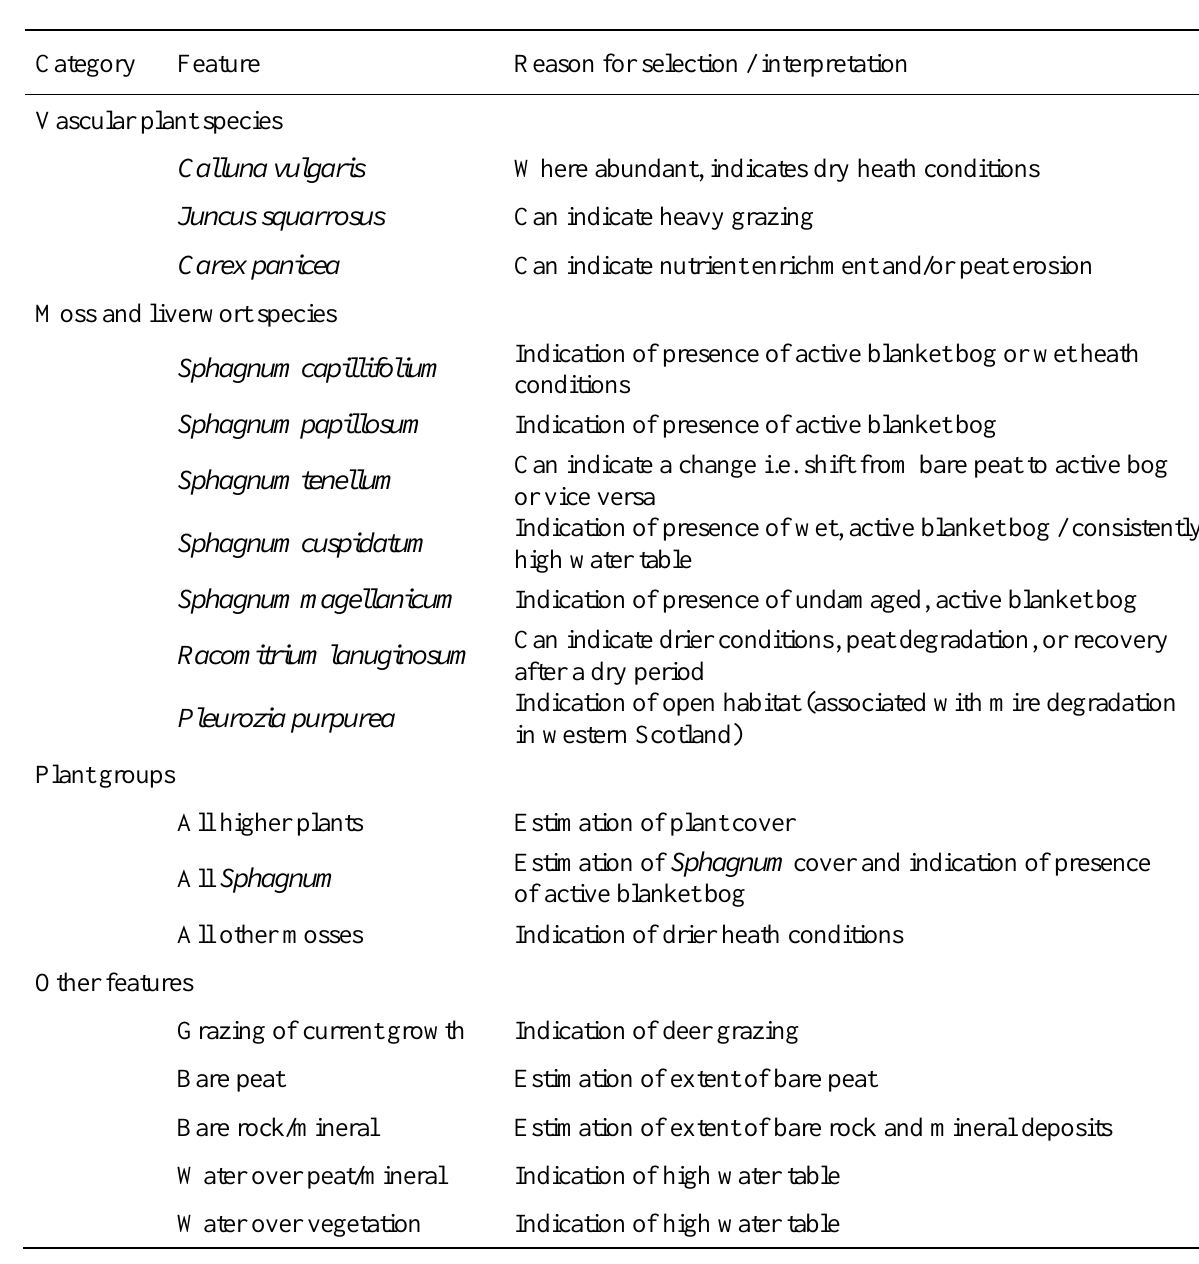
Table 1. Plants and other features recorded during fine-scale ground cover surveys. The reasons for selecting these features, and their interpretation, were based on expert advice on interpreting upland vegetation in the region, as set out in MacDonald et al . (1998) and further described in Lindsay et al. (1988) and Averis et al. (2004). Full scientific names including authority are given in the text, apart from Pleurozia purpurea